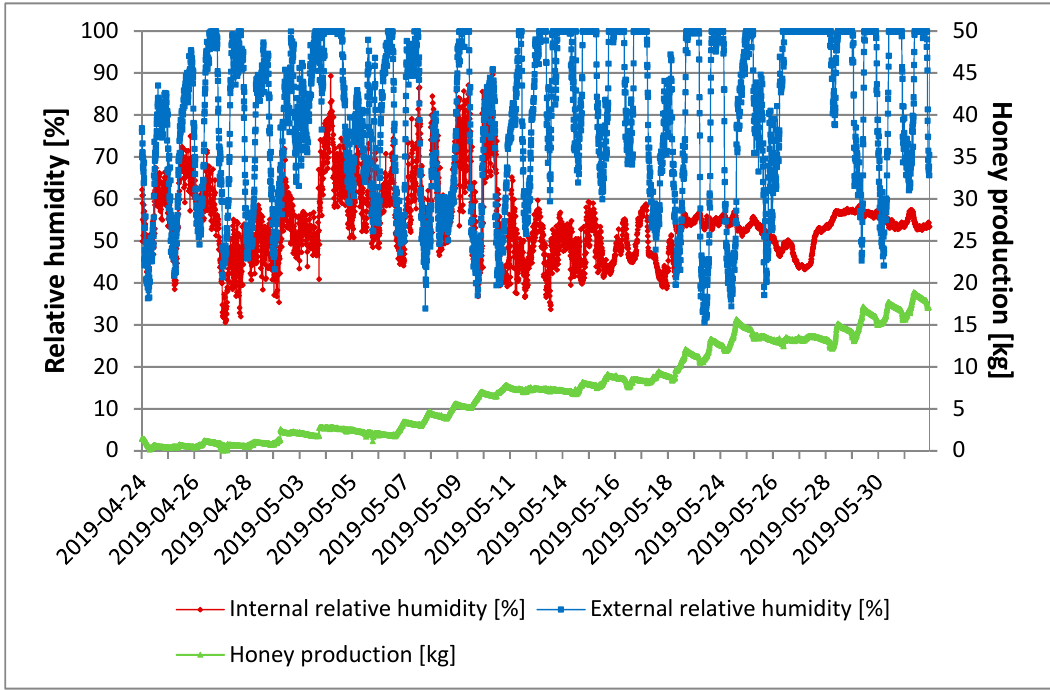
Figure 8. Daily quantity of honey produced as a function of internal and external relative humidity of the hive (data are the mean of three replicates).